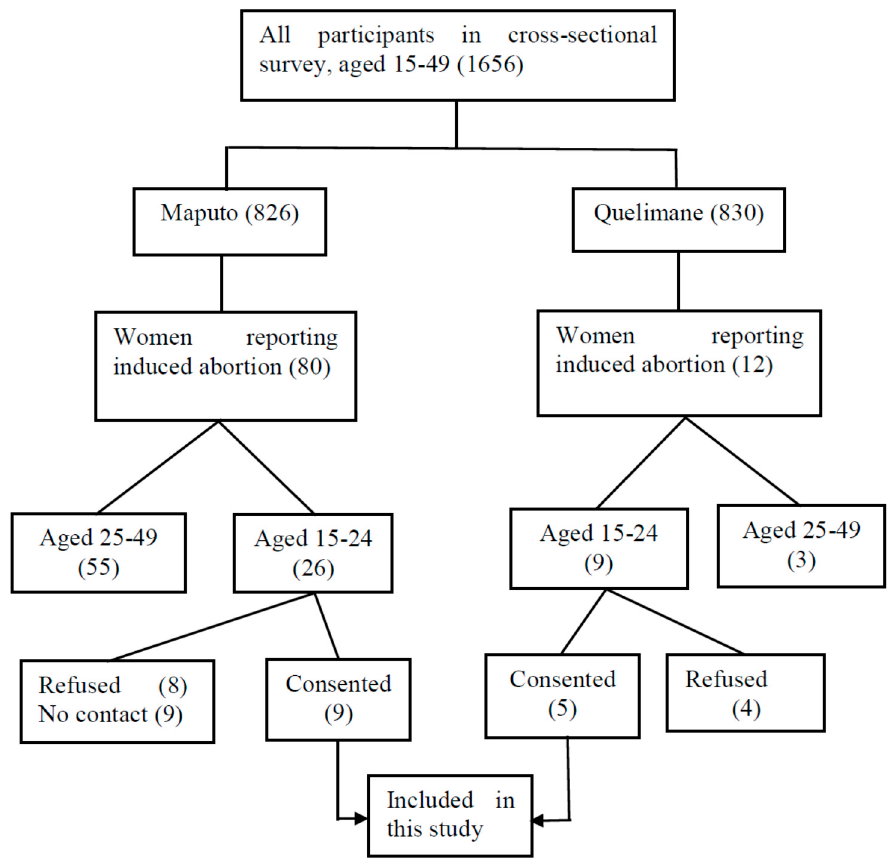
Figure 1. The process of recruitment of the participants.